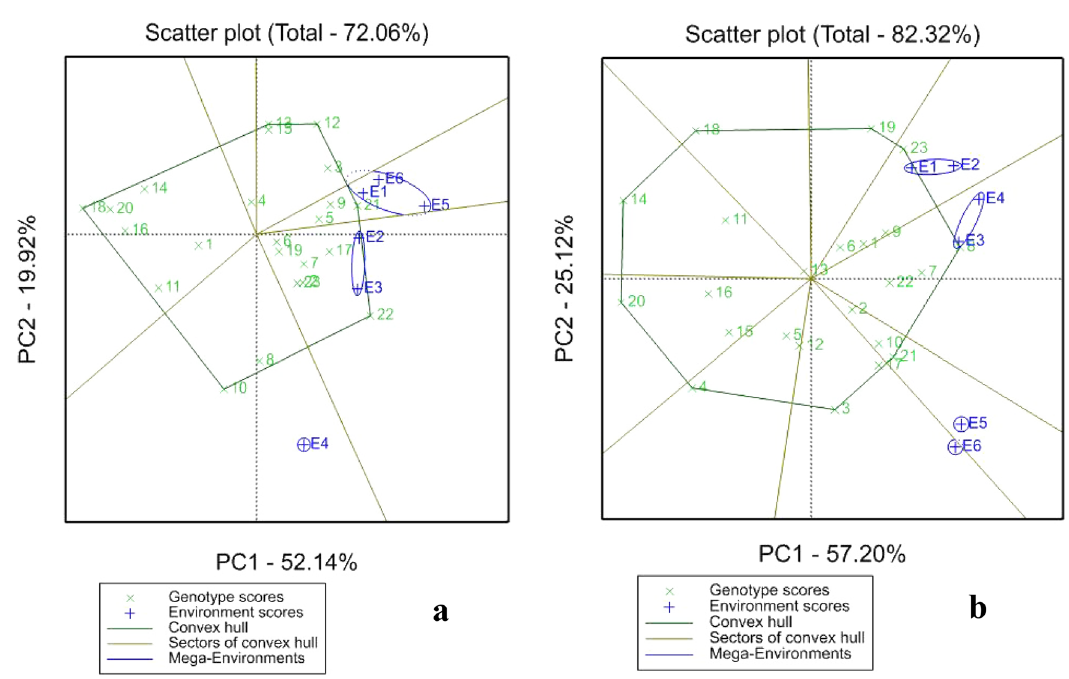
Figure 4. GGE Biplot showing genotypes performance according to their respective environments under drought ( a ) and irrigation ( b ) for root dry matter